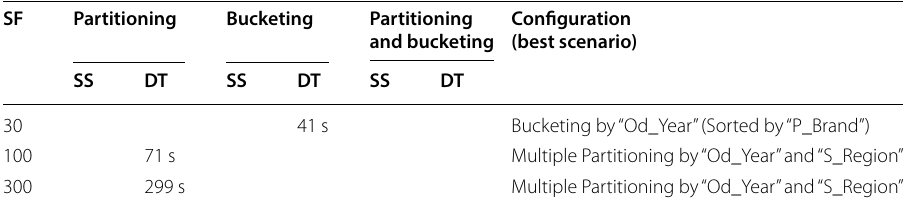
Table 18 Best configuration and processing time by